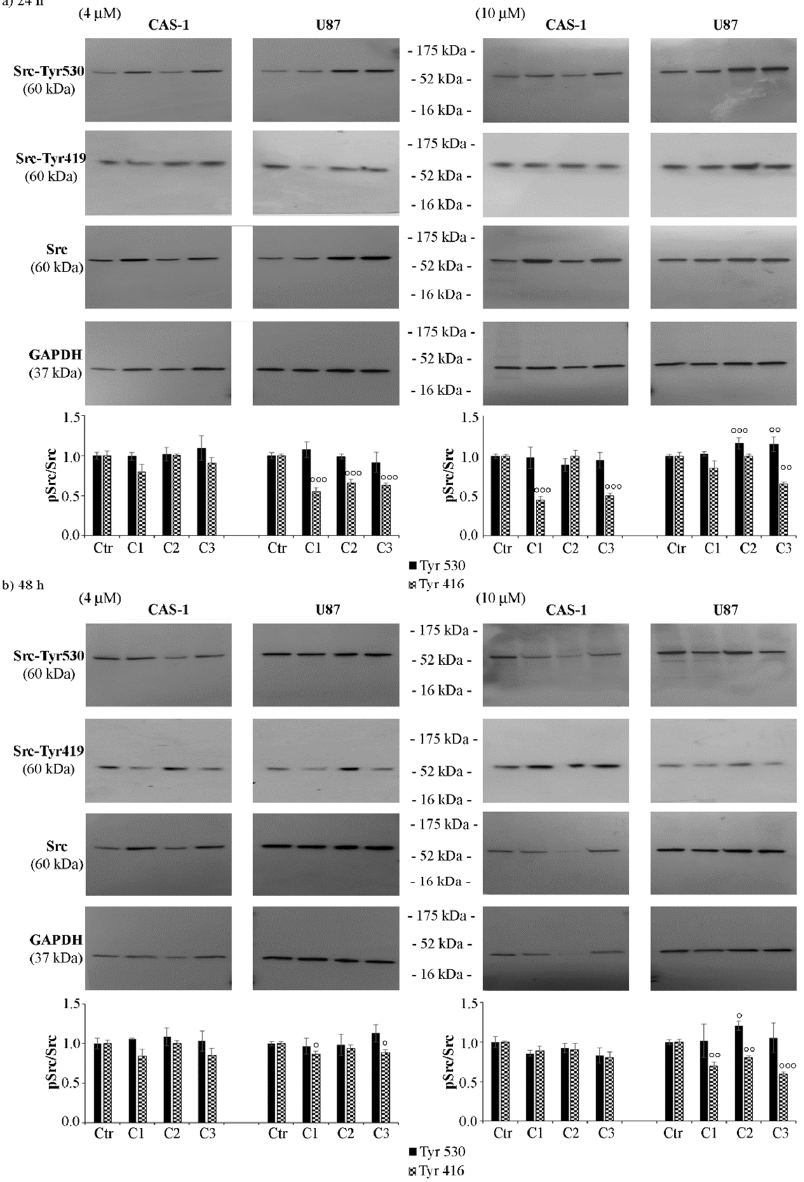
Figure 5. SI306 derivatives inhibit Src activity in U87 cells. Src inactivation was evaluated by immunoblot analyses of p-Src (Tyr530 and Tyr419) and total Src. The expression levels of p-Src and Src were evaluated in CAS-1 (left panels) and U87 (right panels) cells exposed to 4 µ M and 10 µ M of compound 1 (SI306, C1), compound 2 (C2), and compound 3 (C3) for 24 h ( a ) and 48 h ( b ). Immunoblots shown are representative of three independent experiments. GAPDH is the internal loading control. Histograms summarize quantitative data of means ± S.E.M. of three independent experiments. Statistical significance of differences was determined by ANOVA followed by Tukey’s test. Data are expressed as a ratio of the levels of p-Src to the levels of total Src. ◦ p < 0.05 vs. untreated cells; ◦◦ p < 0.01 vs. untreated cells; and ◦◦◦ p < 0.001 vs. untreated